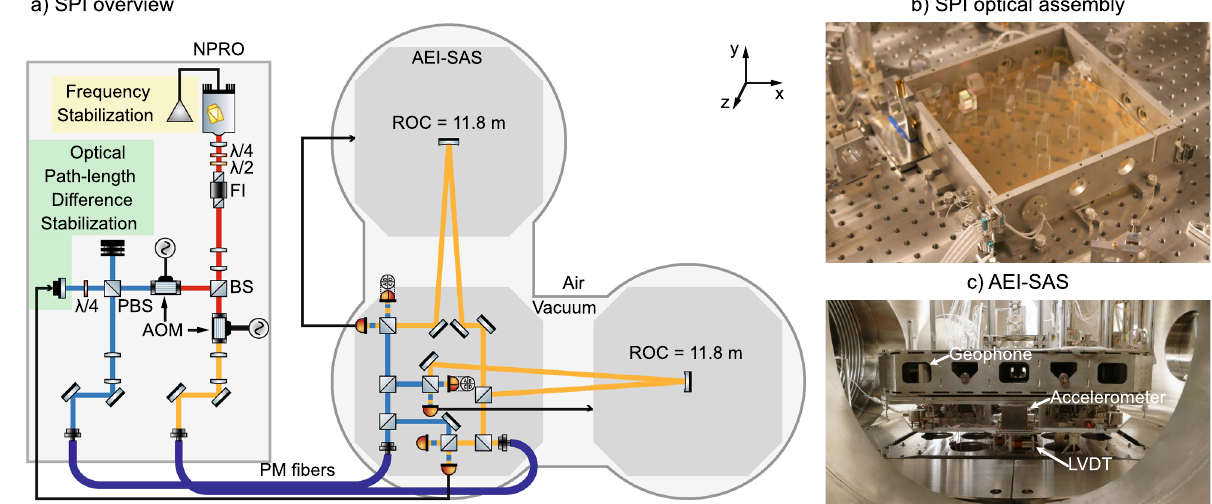
Figure 3. The simplified schematic shows the length sensing of the SPI in the AEI 10 m-prototype. The vacuum system houses the interferometer optics. The light is injected via optical fibers. On the left side of the schematic is the laser preparation for the SPI. In the upper right photograph the SPI hardware can be seen. An aluminum cover protects the central optics during operation. They are assembled on a ULE base plate. The AEI-SAS is shown in the bottom right photograph with some of its internal instrumentation labelled. The SPI is sitting in the center on top of the central AEI-SAS platform. The degrees of freedom are: Length along the y-axis, pitch around the x-axis and yaw around the z-axis. The AEI-SAS in the right half of the schematic overview was not installed at the time of the